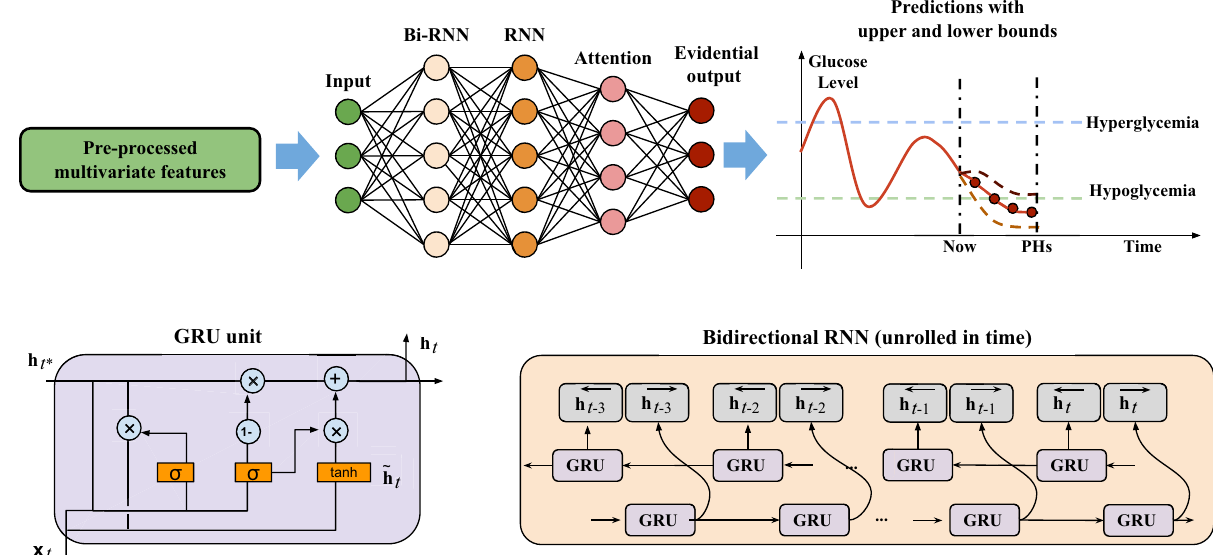
Fig. 6 Architecture of the deep learning model. A stack of bidirectional RNN (Bi-RNN) and RNN with GRU cells is used to extract hidden representations from the input multivariate time series. With the weighted state vector by attention layer, the evidential output computes glucose predictions along with model